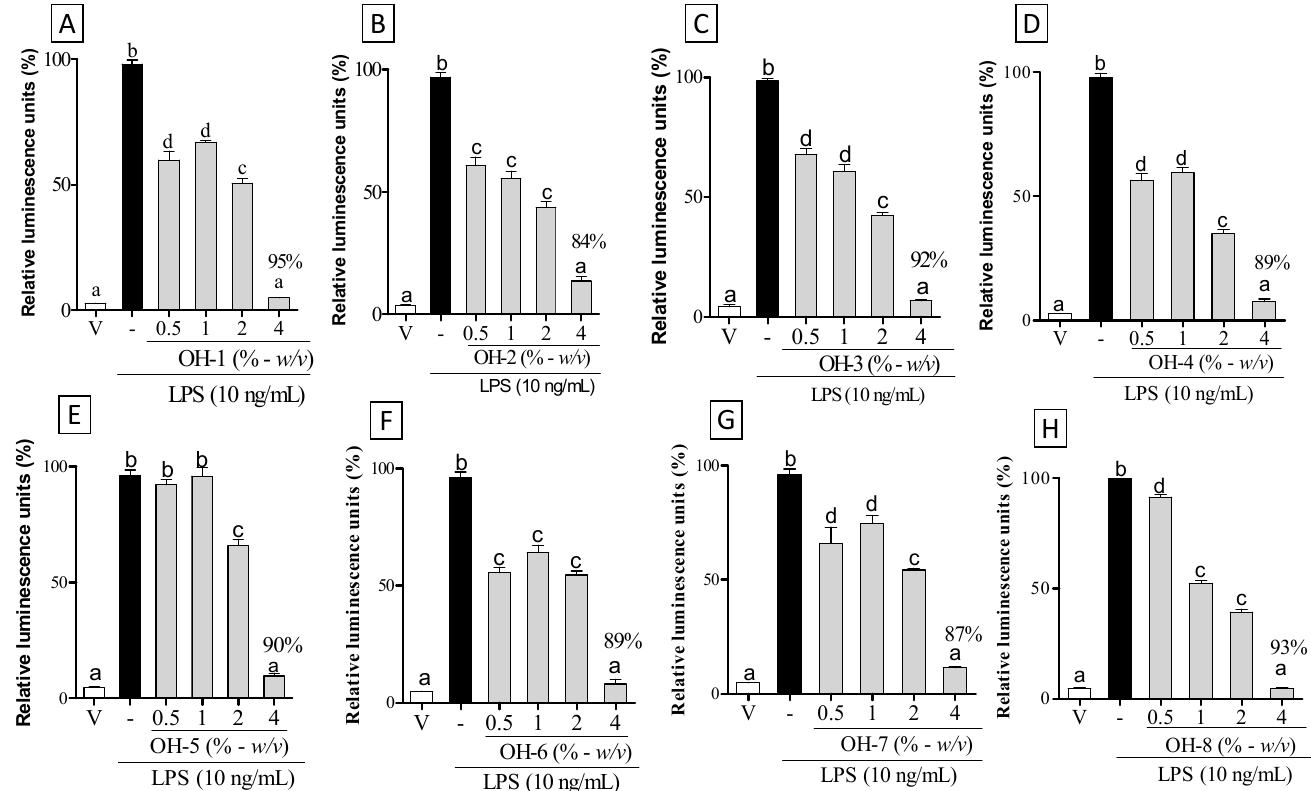
Figure 2. Anti-inflammatory potential of organic honey. To evaluate NF- κ B activation, macrophages were treated with vehicle—V (RPMI medium) and LPS (-, 10 ng/mL): ( A ) OH-1, ( B ) OH-2, ( C ) OH-3, ( D ) OH-4, ( E ) OH-5, ( F ) OH-6, ( G ) OH-7, and ( H ) OH-8 in different concentrations (% - w / v ) for 30 min before LPS stimulation. The negative control group received 0.9% saline (vehicle—V). Different letters indicate statistically significant intragroup differences ( p < 0.05; one-way ANOVA, followed by Tukey’s post-hoc test).